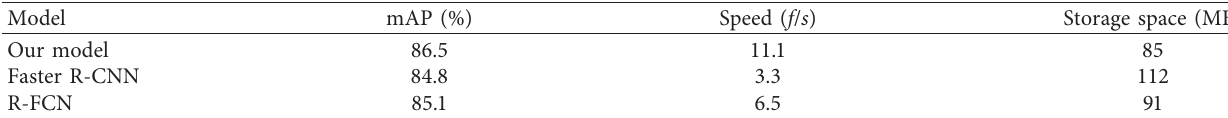
Figure 5: The kinds of different NITR pathways. (a) is the NW path, (b) is the N path, (c) is the NE path, (d) is the NW +N path, (e) is the NE +N path, (f) is the NW+NE path, and (g) is the NW +N +NE path. Table 2: Comparison of performance of different models.